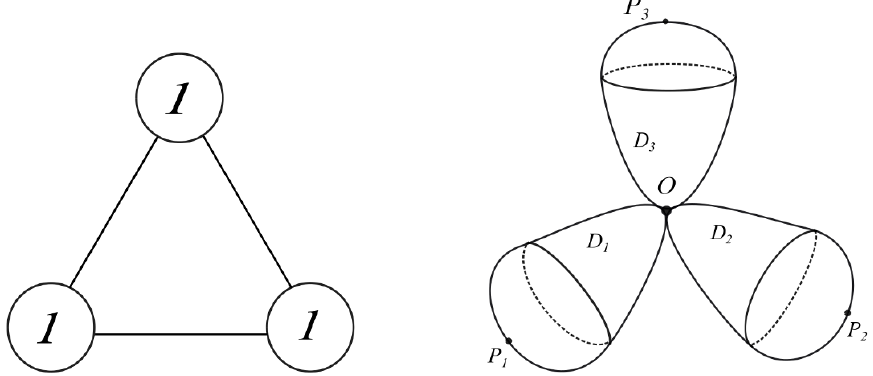
Figure 2. Left: the a(cid:14)ne A 2 Dynkin diagram, with Dynkin label indicated at each node. Right: the nilpotent cone of singular (cid:12)bration, consisting of three C P 1 intersecting at O . The spheres are distorted a little to accommodate the common intersection. Together with P 1 , P 2 and P 3 ,